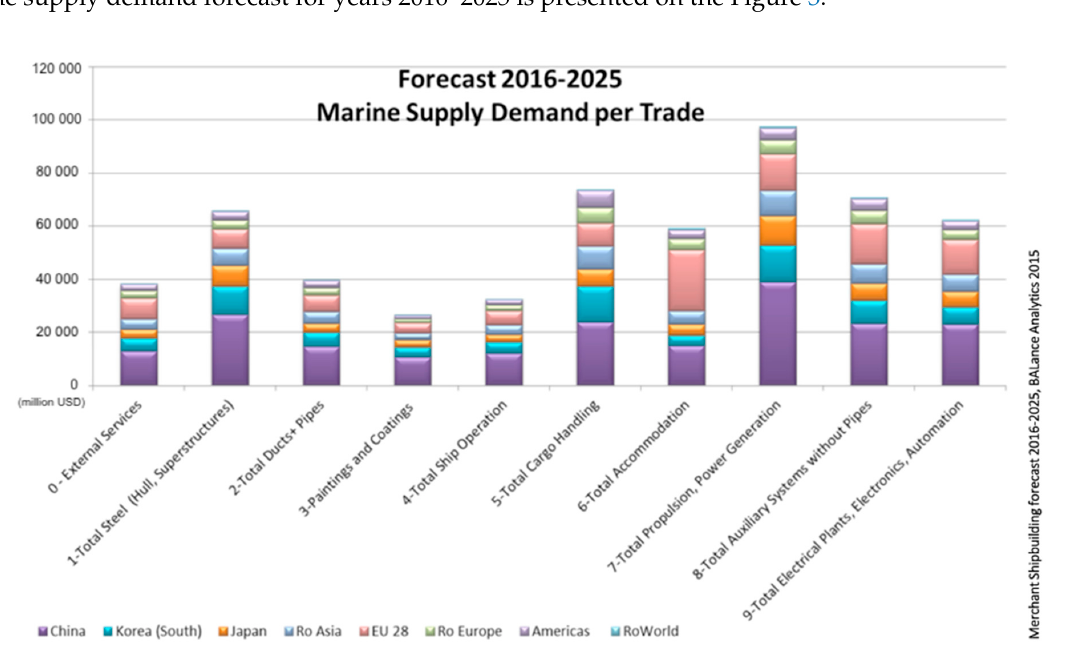
Figure 3. Marine supply demand per trade [25].